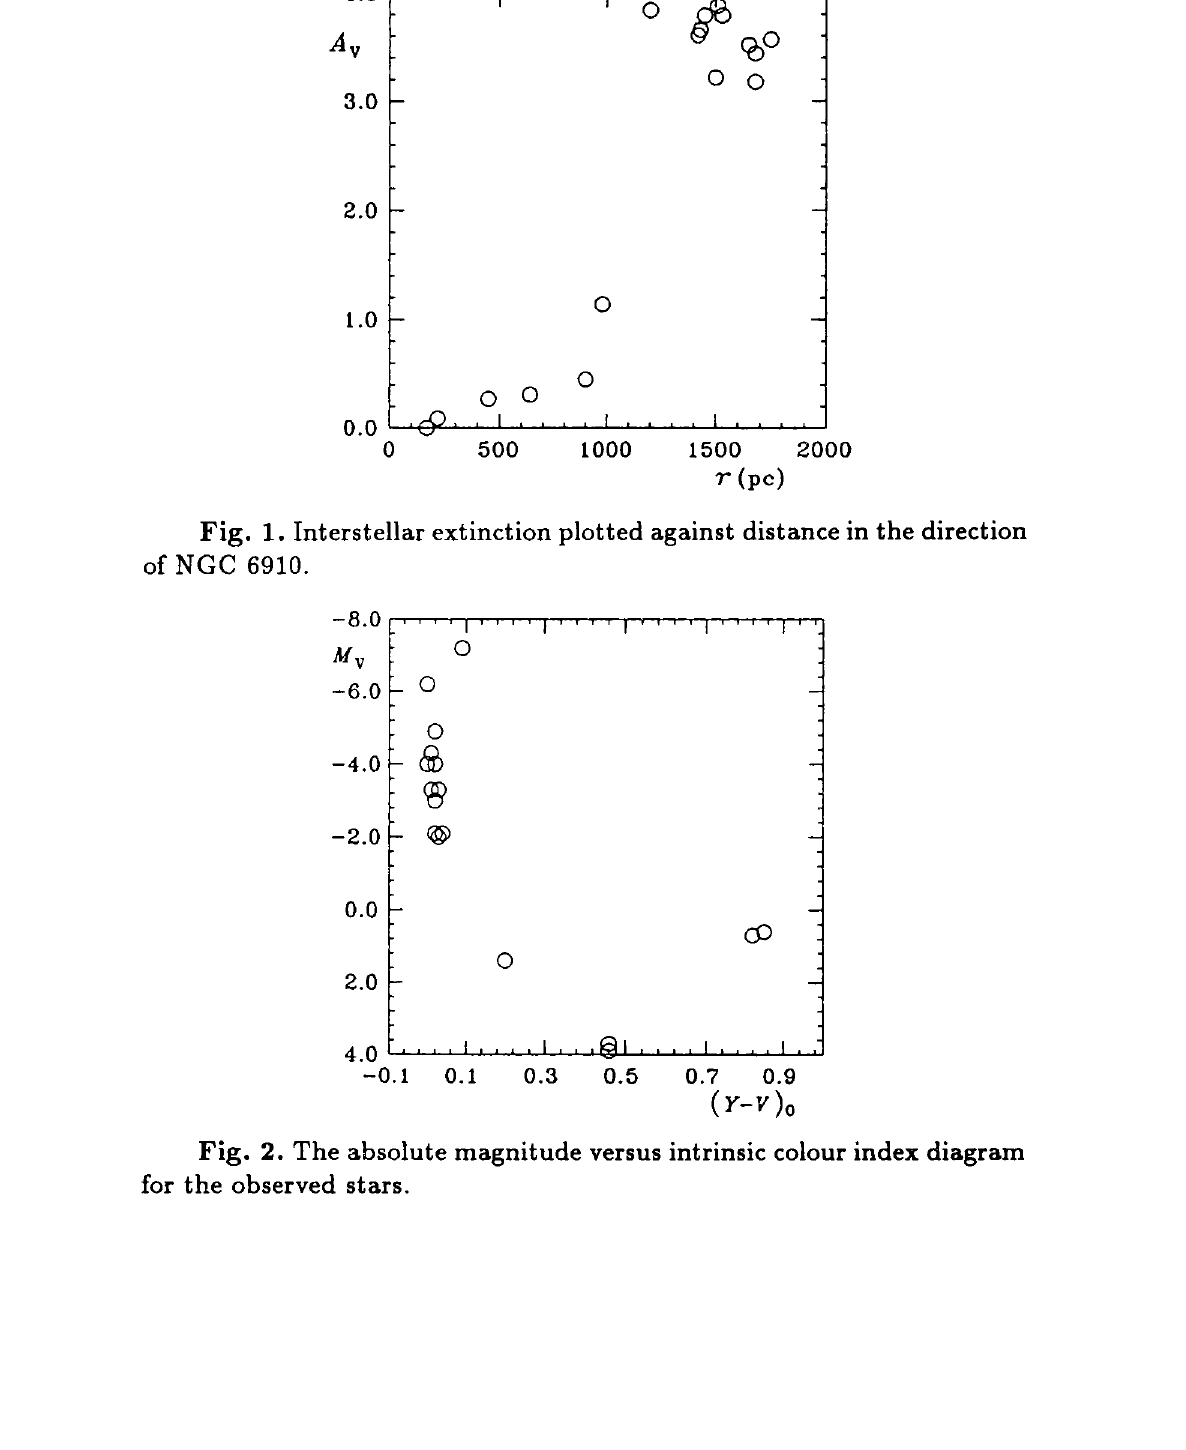
Fig. 1. Interstellar extinction plotted against distance in the direction of NGC 6910.